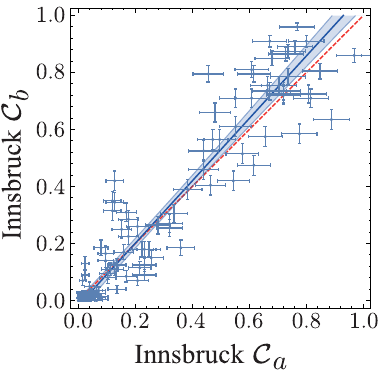
FIG. 6. Comparison between experimental outcome probabil- ities for the circuits C a and C b on the Innsbruck device. Linear total least-squares regression (solid blue line) yields a regression slope of 1.09(2) compared to the ideal value of 1 (dashed red line). Experimental error bars correspond to 1 σ statistical un- certainty, and the blue shaded bands represent 3 σ mean prediction intervals for the